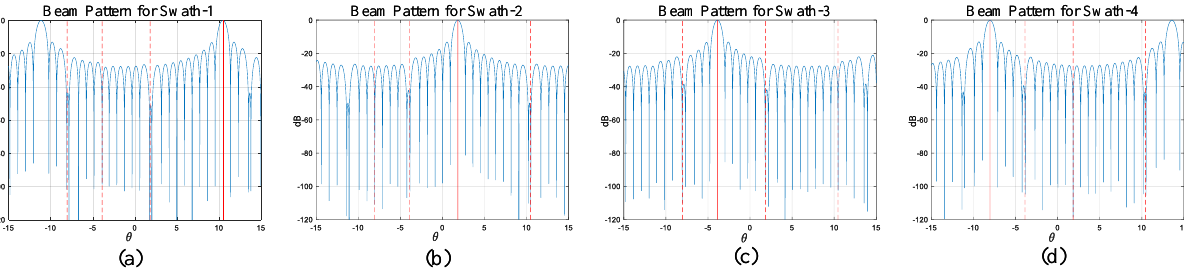
Figure 16. The beam patterns generated by the conventional single-null constraint scheme.